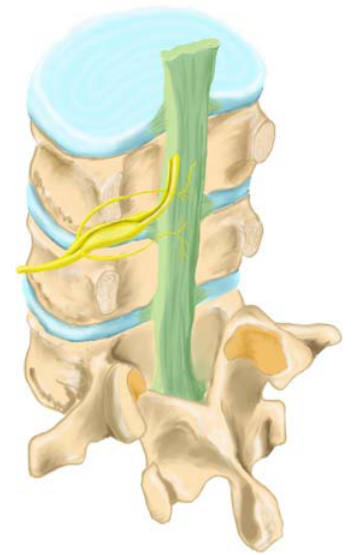
Figure 3. Sensory innervation of the posterior longitudinal ligament (green) and the disc annulus (blue) occurs by the ascending branch of the sinuvertebral nerve (yellow) (adapted from Raj et al.